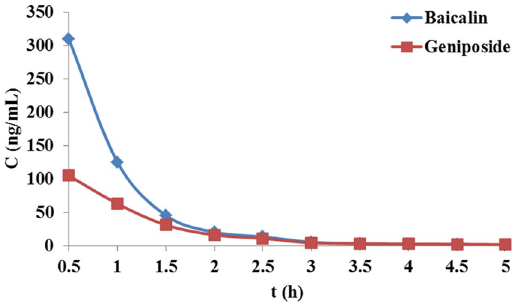
Figure 5. Hypothalamus microdialysates concentration − time courses of baicalin and geniposide in TG rats after intravenous administration of QKLI.